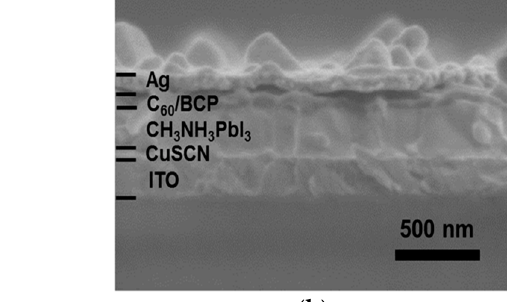
Table 5. Summary of photovoltaic device performance of CuSCN HTMs for PSCs.